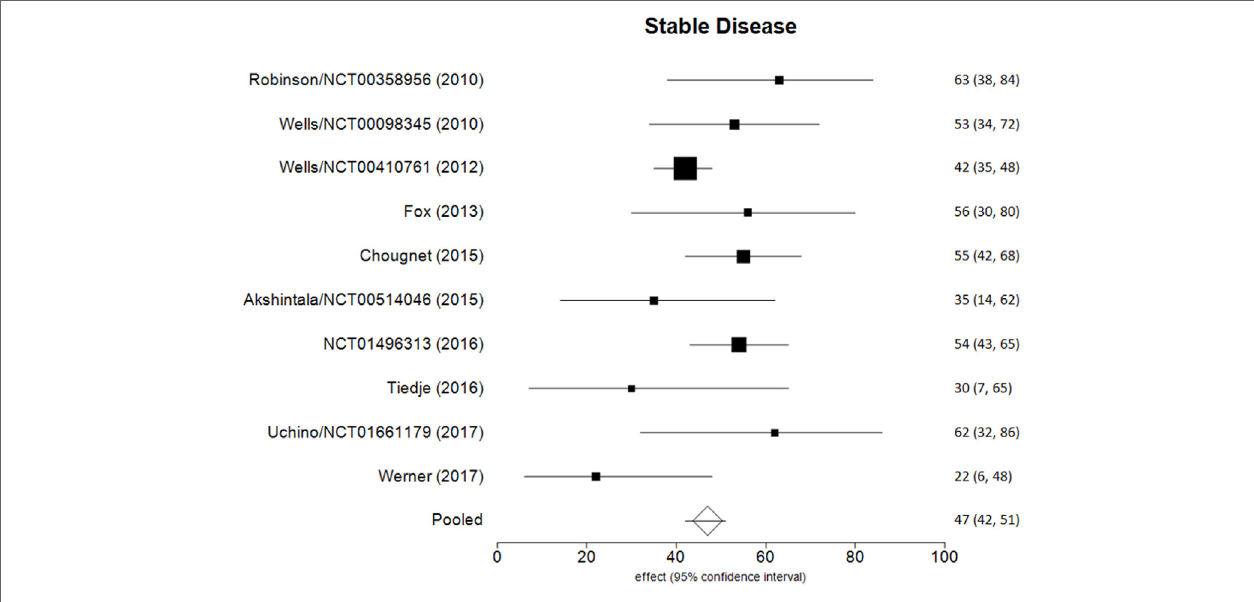
FigURe 3 | Forest plot of data on stable disease (fixed effect).